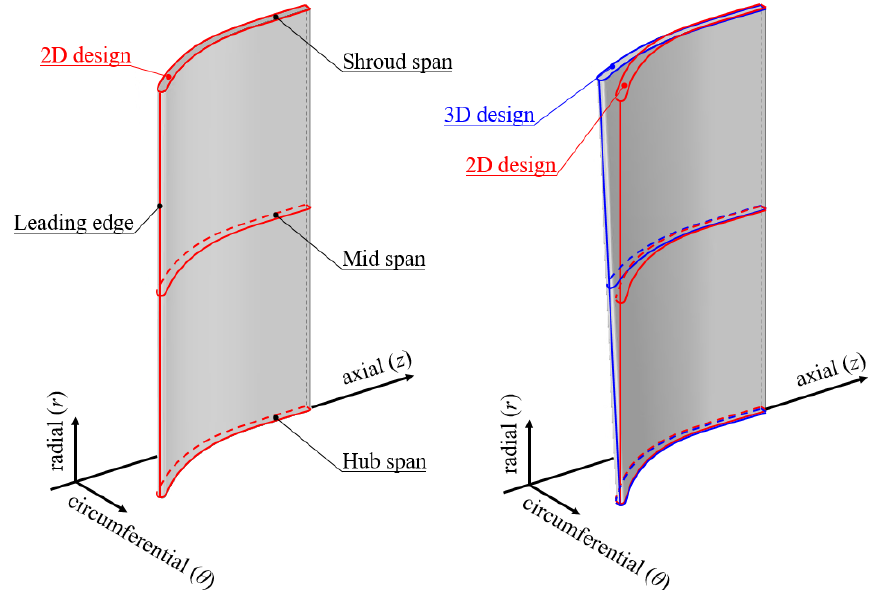
Figure 2. Schematic view of designed guide vane with 2D (red) and 3D (blue) geometry.